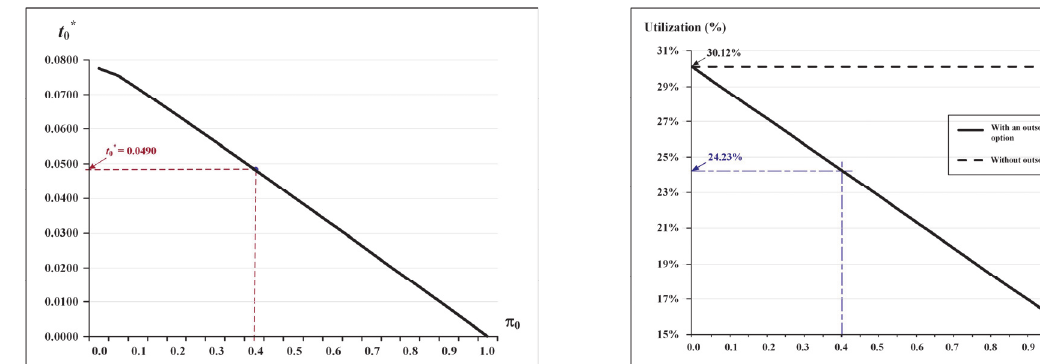
Fig. 7. The effect of differences in common-part outsourcing portions π 0 on t 0 *